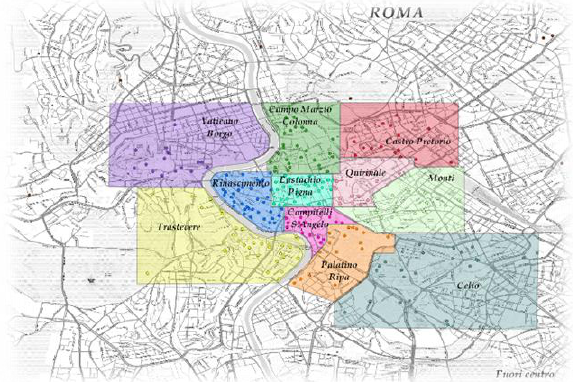
Figure 5. Map of the 11 districts.